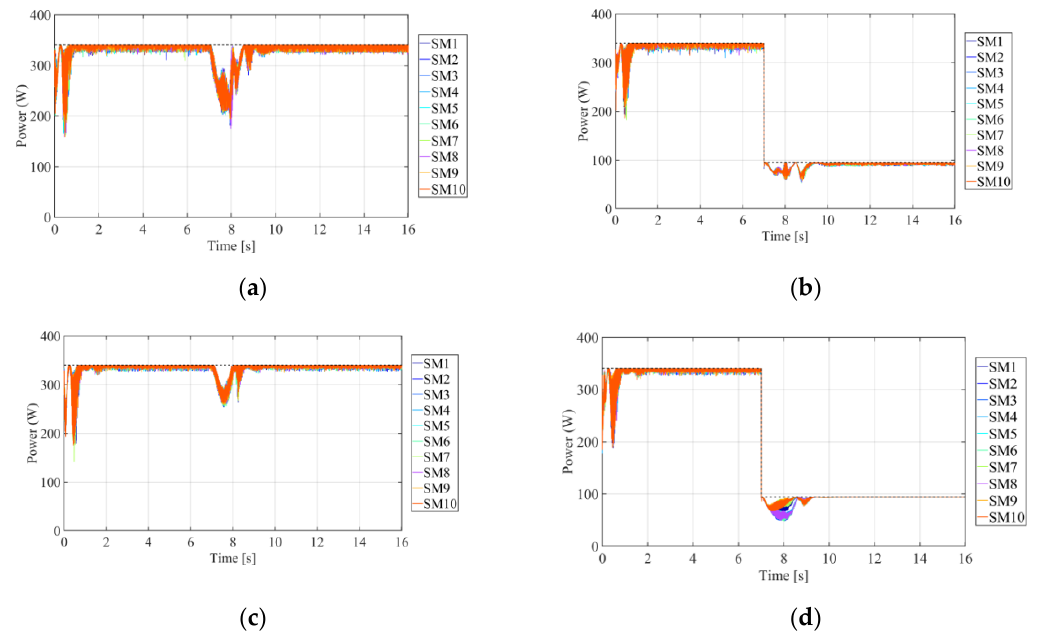
Figure 7. PV module powers: ( a ) CMPPT control—upper arm; ( b ) CMPPT control—lower arm; ( c ) DMPPT control—upper arm; ( d ) DMPPT control—lower arm. The dashed lines represent the maximum available